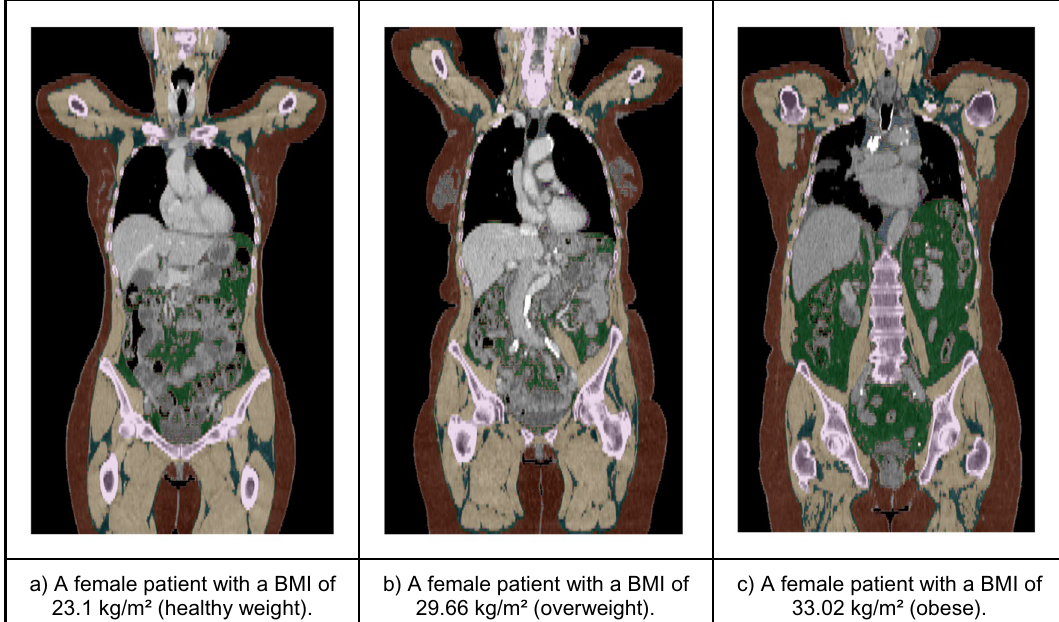
Figure 1. Exemplary full tissue analysis segmentations generated by the BCA network, gathered from patients out of the three BMI-groups. The segmentation shows seven tissues: Muscle (beige), bone (pink), subcutaneous adipose tissue (red), visceral adipose tissue (green), intermuscular adipose tissue (teal), paracardial adipose tissue (light blue), epicardial adipose tissue (purple). The coronal views also illustrate the described patient positioning requested by the CT